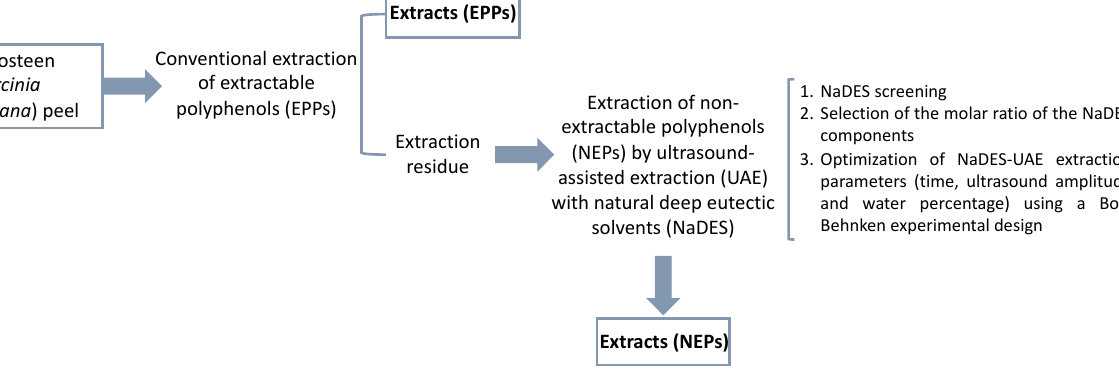
Figure 1. The extraction procedure carried out in this work.